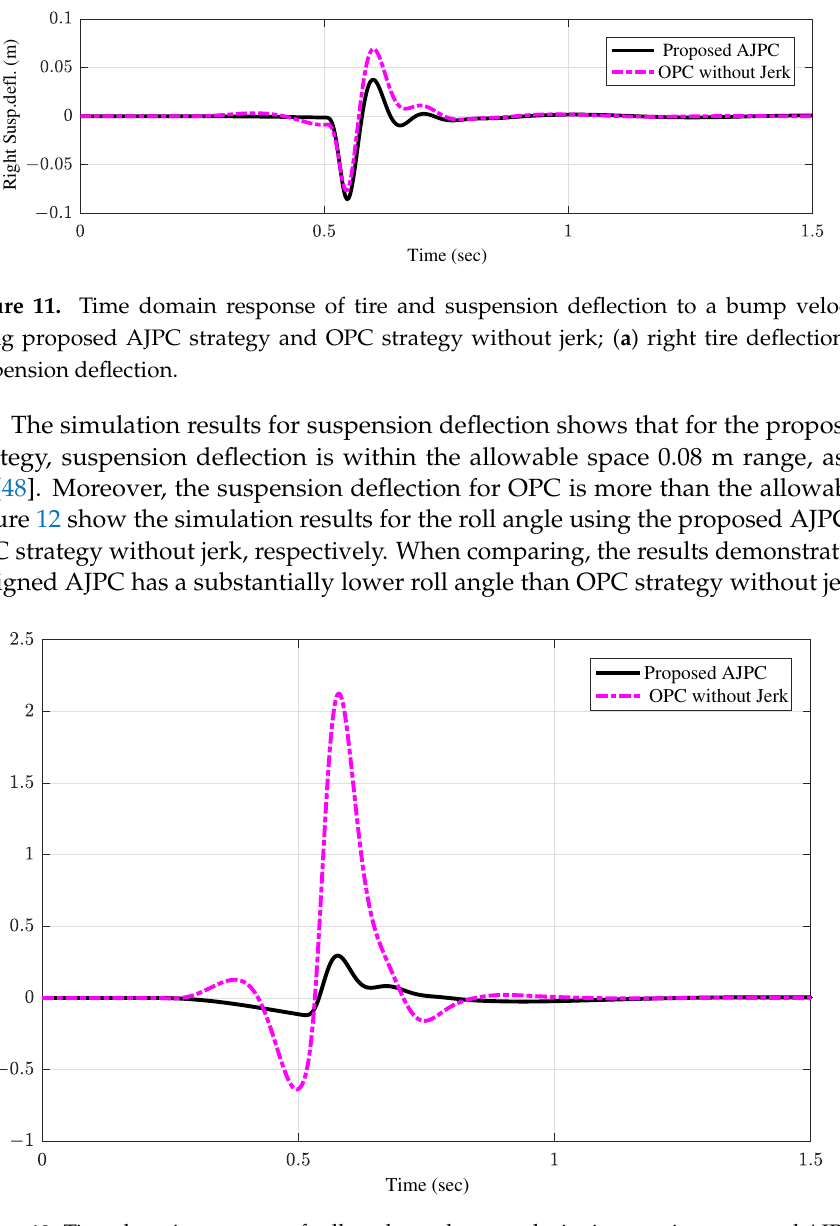
Figure 12. Time domain response of roll angle to a bump velocity input using proposed AJPC strategy and OPC strategy without